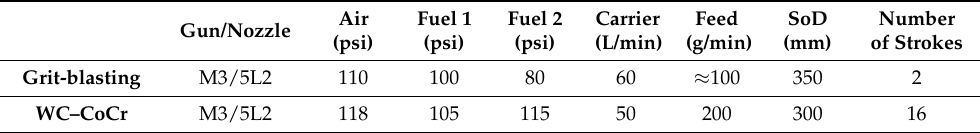
Table 2. Grit-blasting and spraying parameters